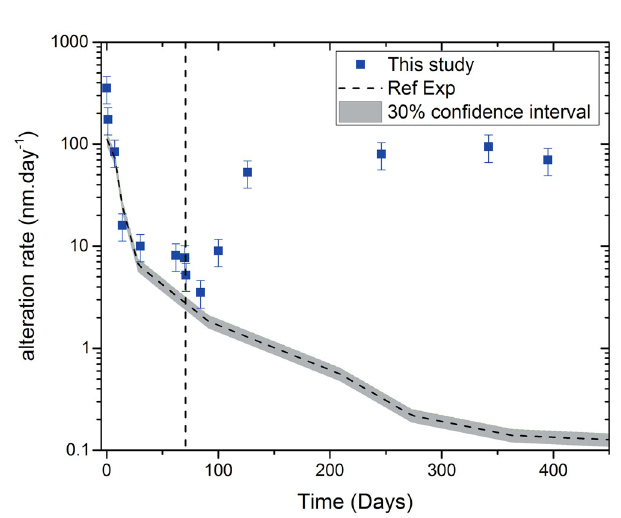
Fig. 2 Rates of alteration calculated based on a linear regression of the equivalent thickness determined at each time point. The gray dotted line represents the rates observed for the reference experiment with a 30% con fi dence interval ( gray shading ). 30 The black dotted line represents the addition of magnetite at day 70